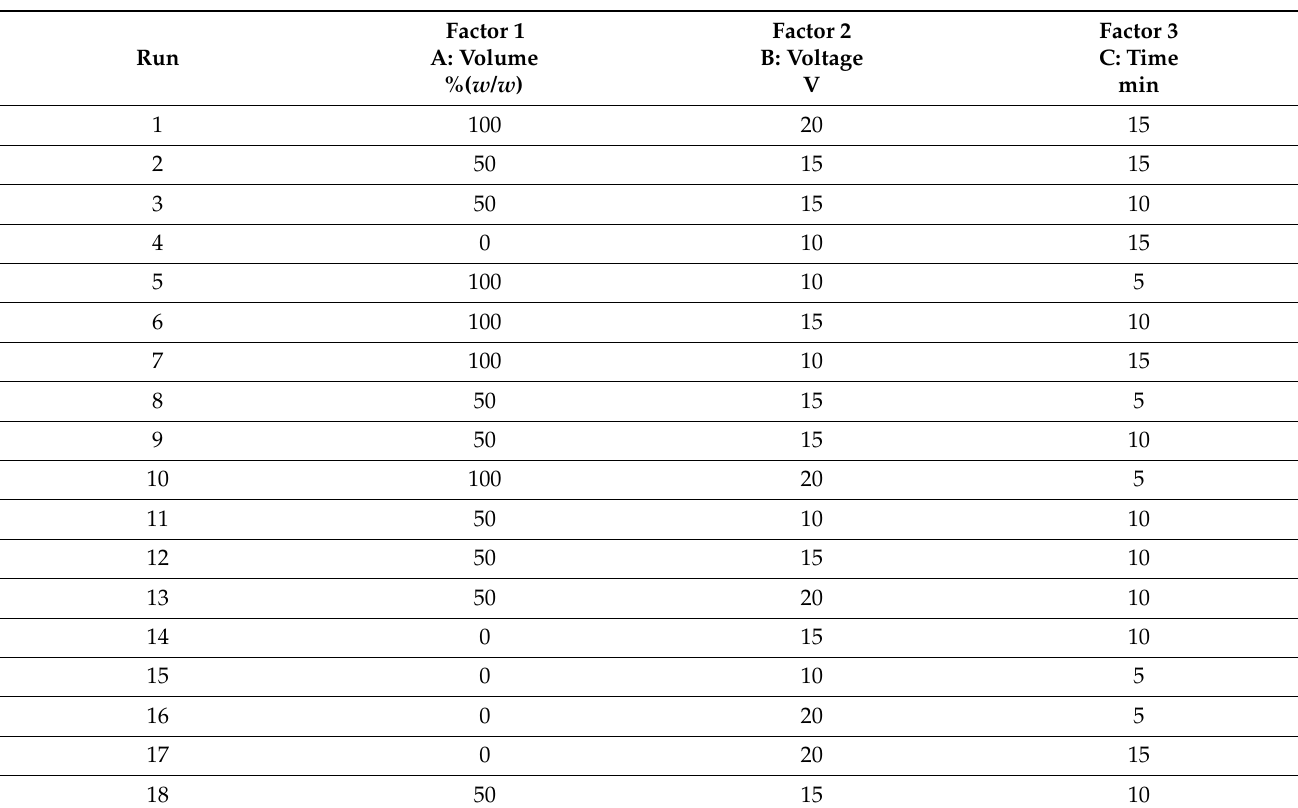
Table 3. Experimental design for a volume ratio of 0%, 100%